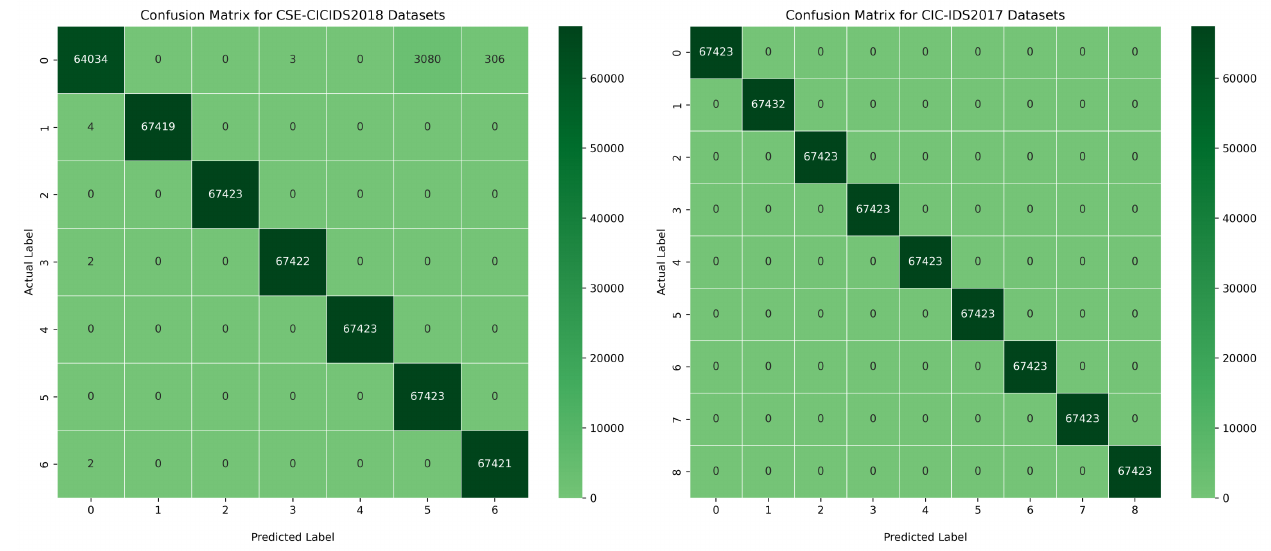
Figure 6. Confusion matrix for